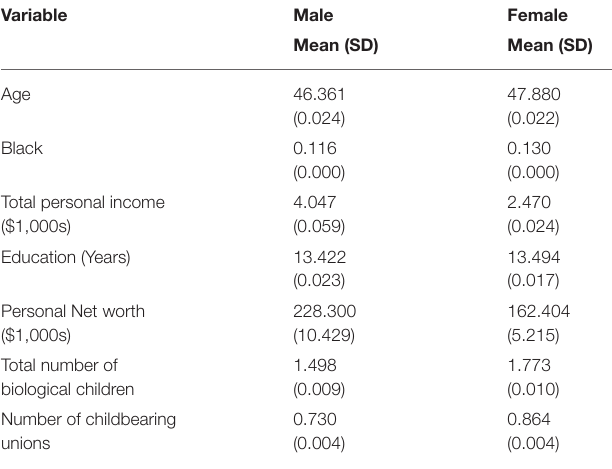
TABLE 1 | Means and standard errors, all